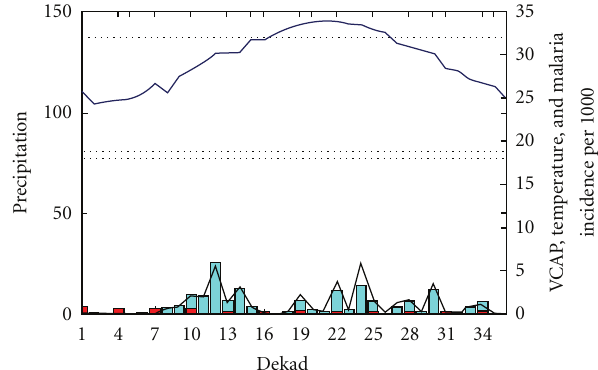
Figure 6: Region 3: the black line represents the VCAP values (low values reaching 5), the blue bar represents rainfall (mm/dekad with values below 25 mm), the blue line represents temperature (high temperature above 25 ◦ C), and the red bar represents malaria incidence per 1000